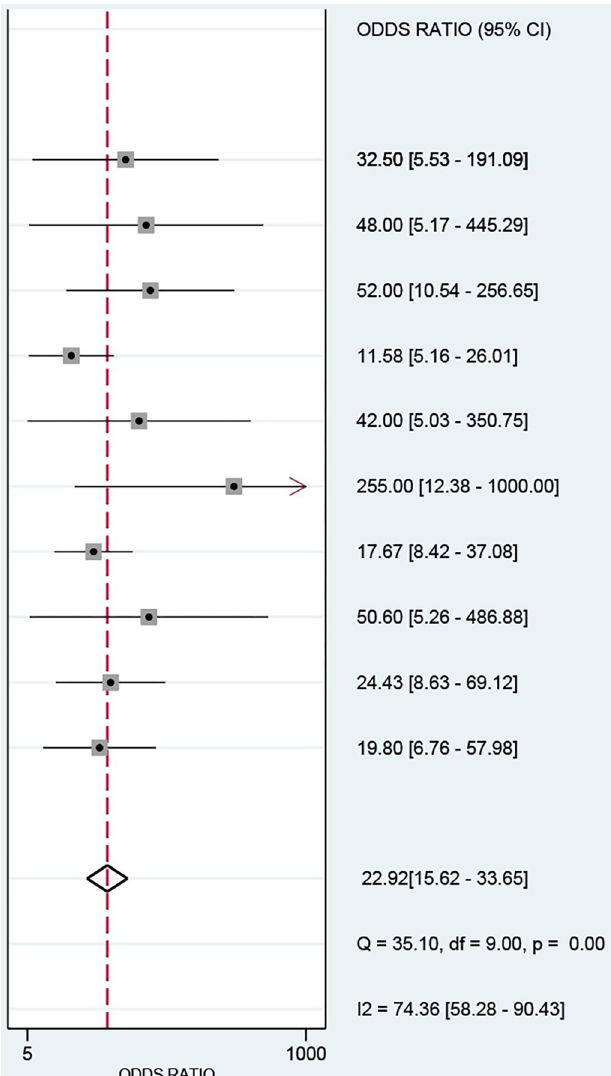
Fig 4. Forest plot for the association of serum creatinine and mortality of paraquat poisoning.